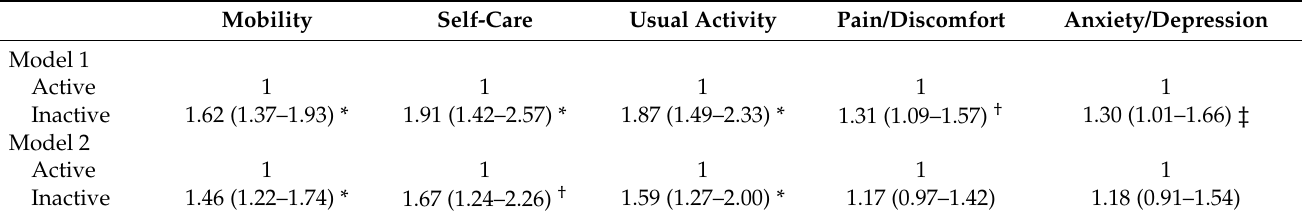
Table 3. Association between physical activity and each EQ-5D dimension.